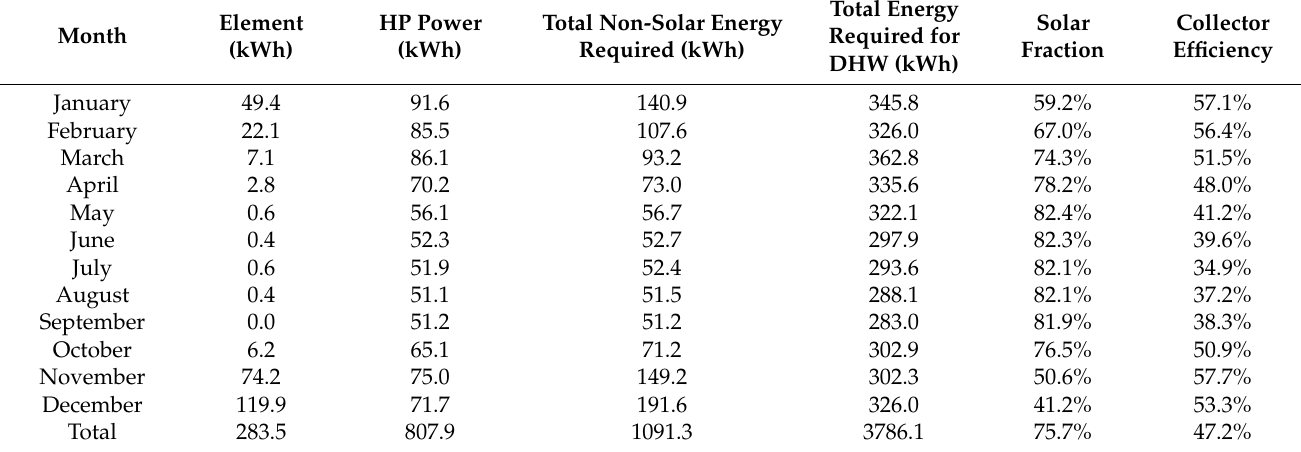
Table 11. MCST-HP system simulation results for Toronto with 45-degree tilt